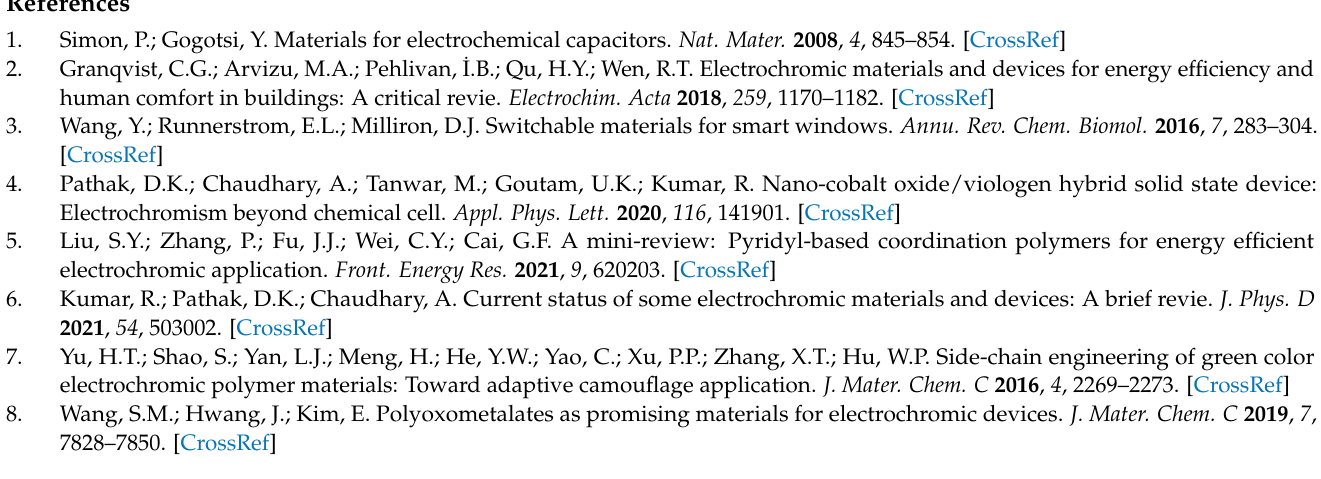
Figure S5: Ti 2p spectra of PANI/MXene. Figure S6: Equivalent circuits that optimally fit with obtained Nyquist plots of PANI/MXene electrodes. Figure S7: Comparison of various UV-vis transmittance spectra of PANI/MXene film performed at different mass rates. Table S1: